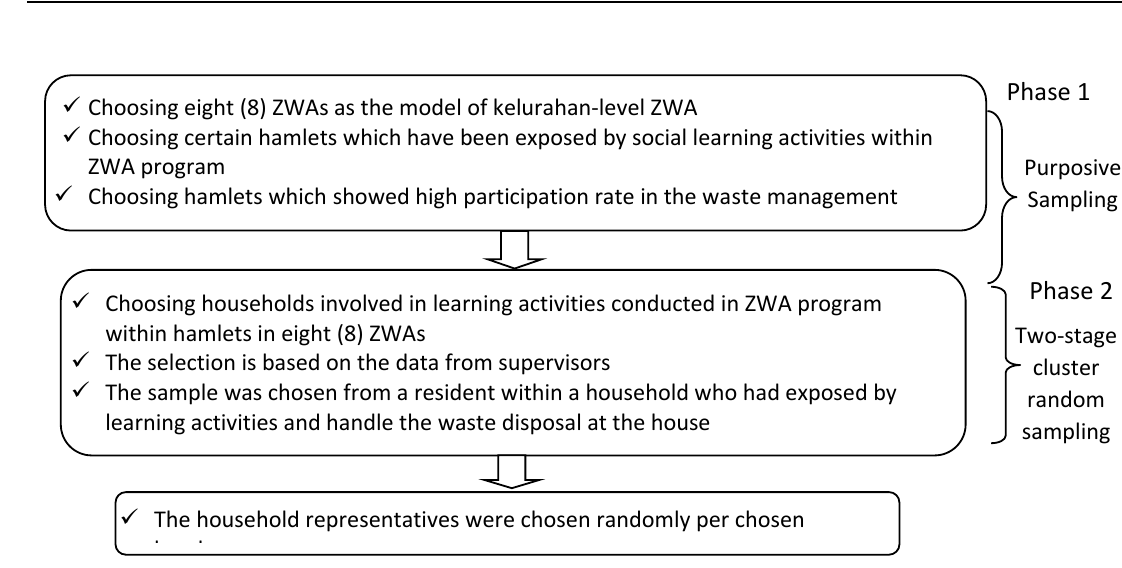
Fig 1. Sampling Selection of the Study Fig. 3: Sampling technique for the Fig. 3: Sampling technique for the respondents